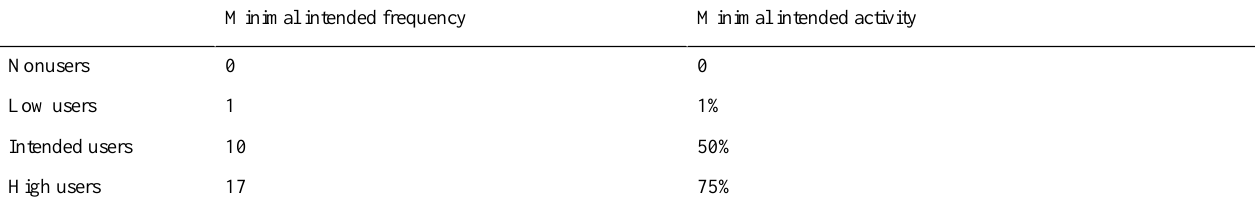
Table 1. Classification of user groups based on minimal intended frequency and